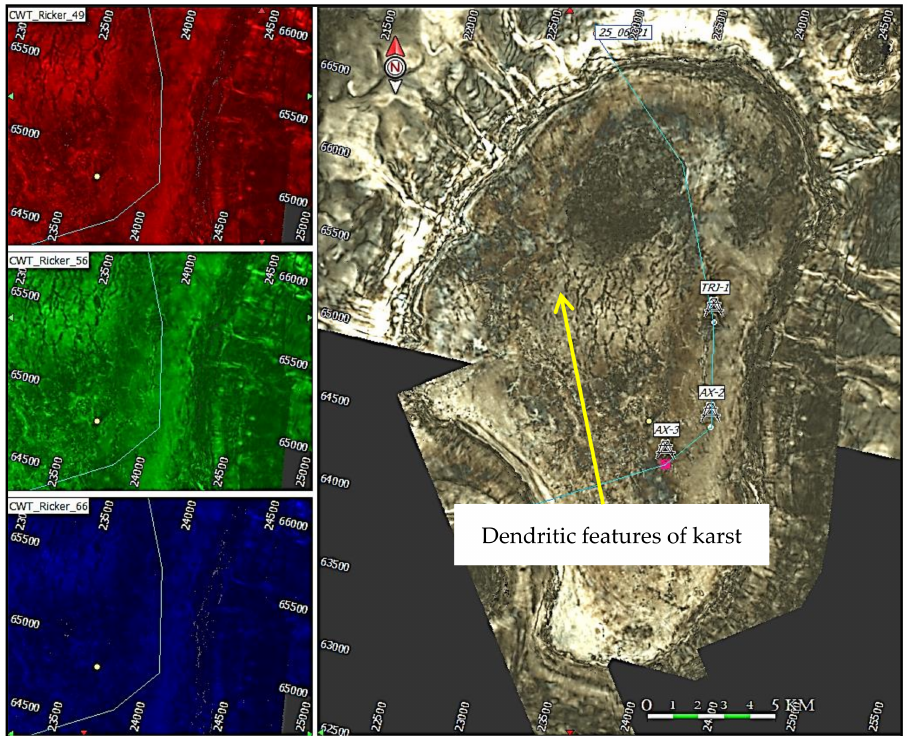
Figure 8. Red, green and blue (RGB) blending technique and co-rendering of extracted frequencies in